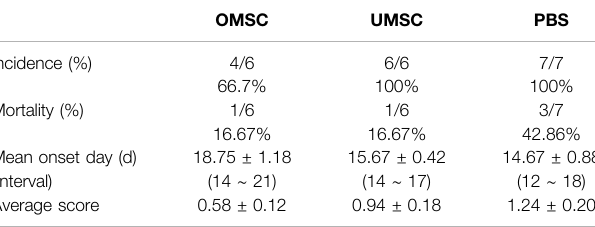
TABLE 1 | Clinical characteristic of EAE mice treated with